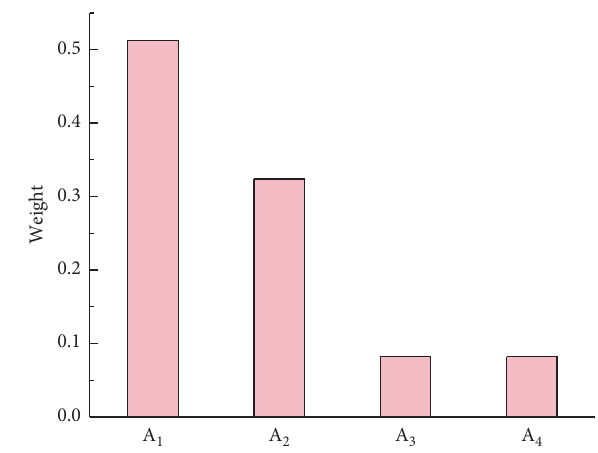
Figure 9: Schematic diagram of traditional AHP criterion layer weights.